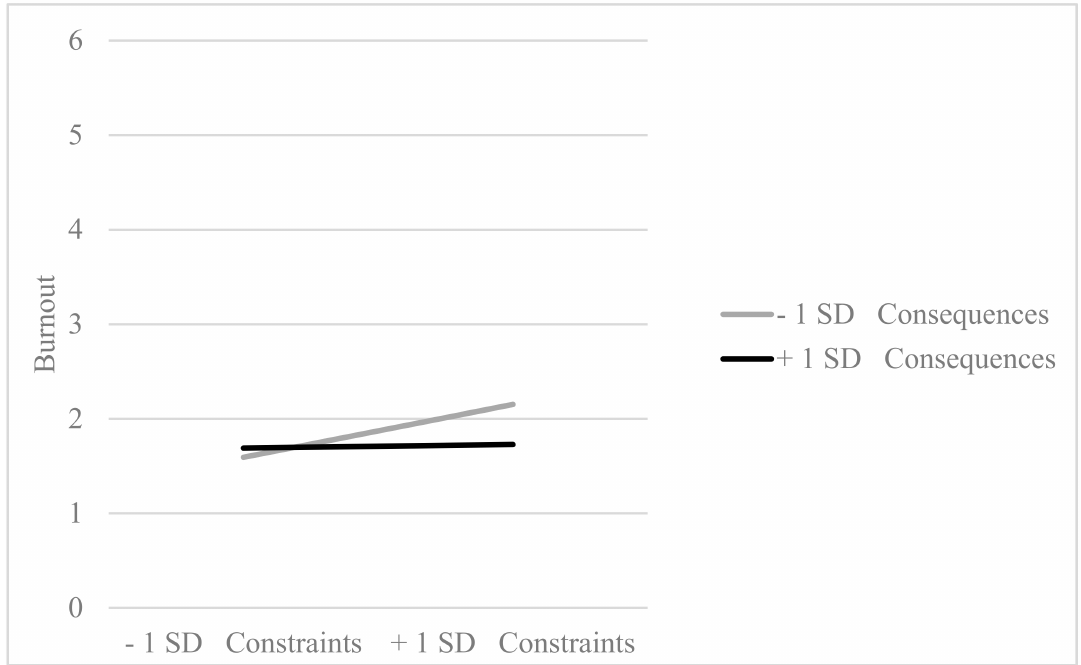
Figure 2. Interaction effect between constraints and consequences in the office employees’ sample ( β = − 0.11, p =